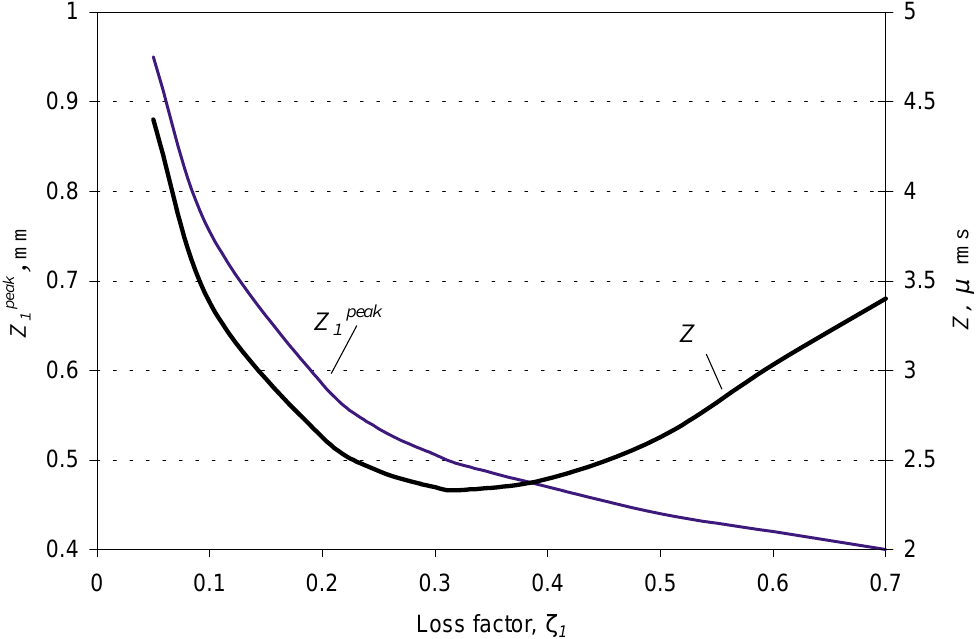
Fig. 13. Analysis of